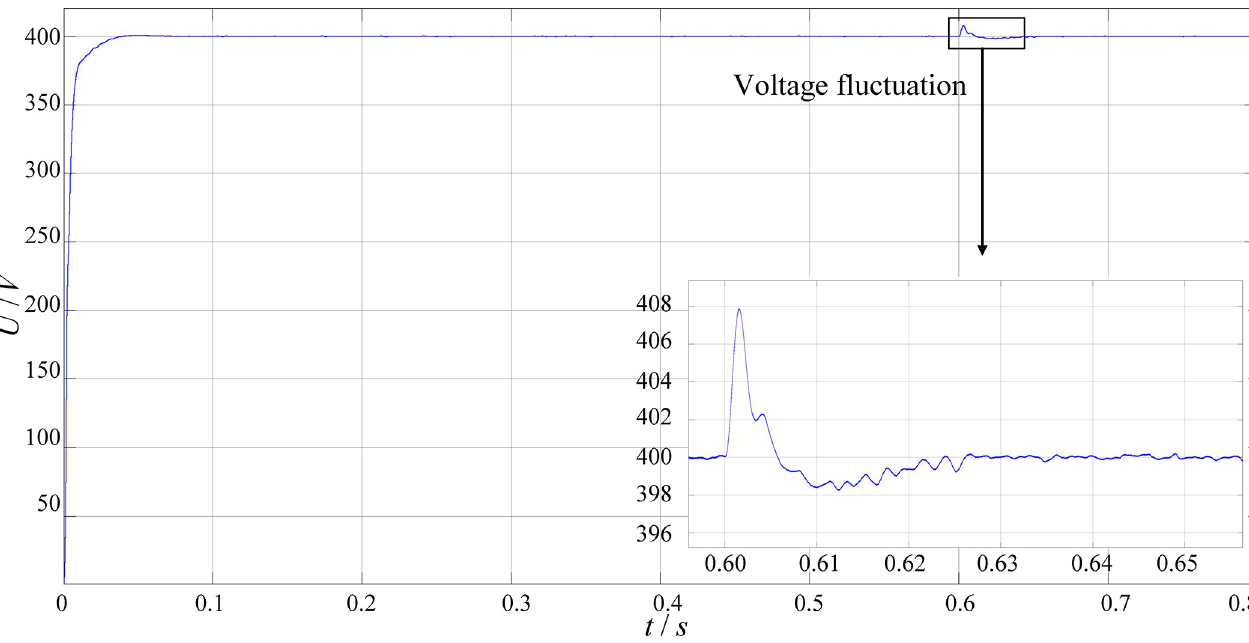
Fig 21. The output voltage waveform of the high-voltage charging circuit